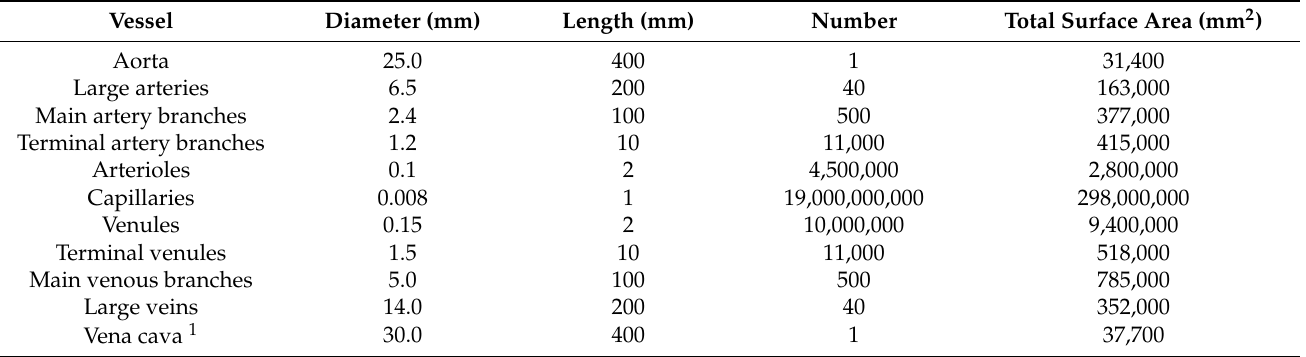
Table 1. Average dimensions and approximate quantifications of vessels in the human circulatory system for a 30-year-old male with a mass of 70 kg. Adapted from